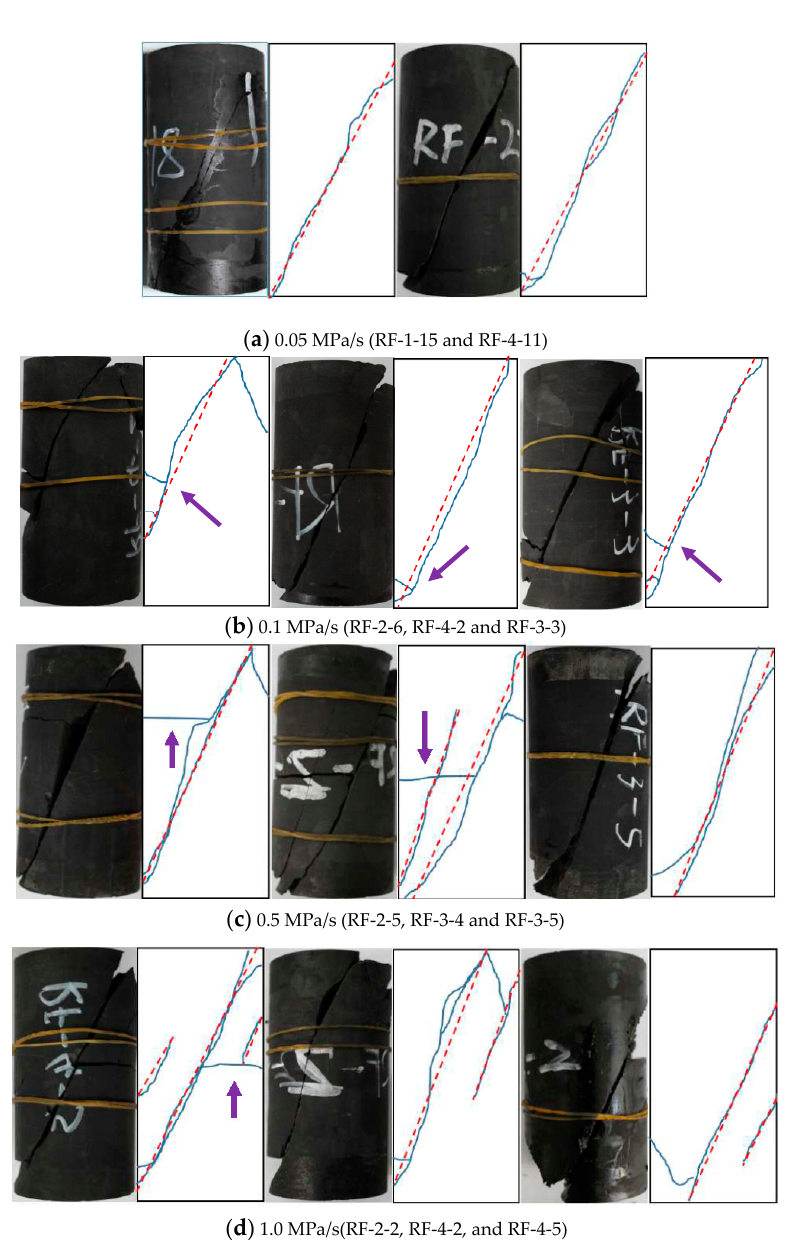
Figure 13. Damage morphologies of shale specimens under different unloading rates.